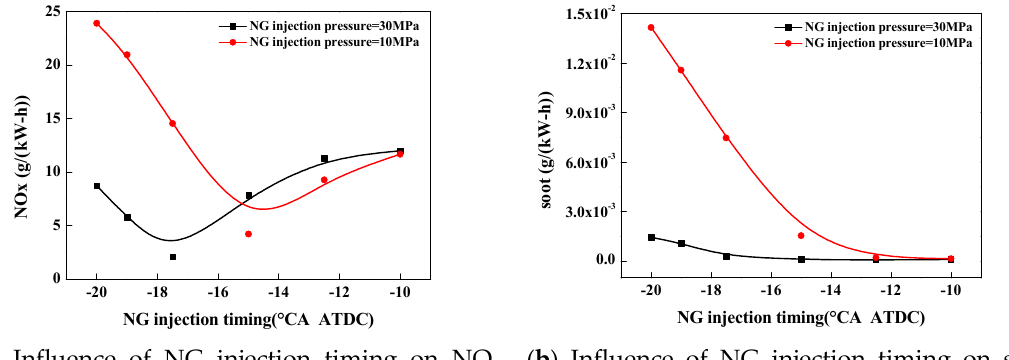
Figure 20. Influences of NG injection timing on NO x and soot emissions.